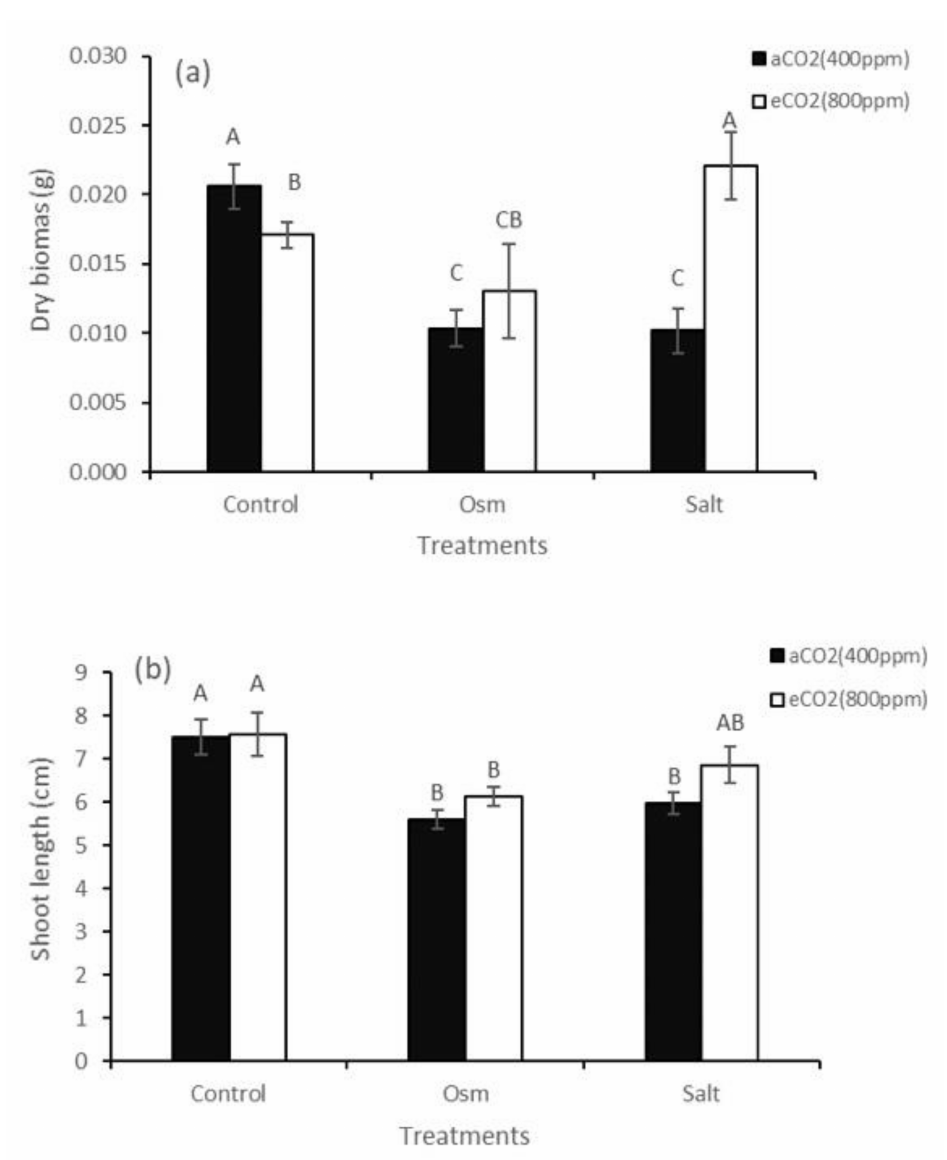
Figure 1. Dry biomass ( a ) and shoot length ( b ) of C 4 -species Kochia prostrata at different CO 2 concentrations (400 and 800 ppm) under moderate (–0.6 MPa) polyethylene glycol (PEG)-induced osmotic stress (Osm) and salinity (Salt) similar in osmotic potential (200 mM NaCl). The values are the means ( ± SE) of seven replicates. Different letters above the bars represent significant differences at the p < 0.05 (Tukey’s pairwise comparison). aCO 2 —ambient CO 2 concentration; eCO 2 —elevated CO 2